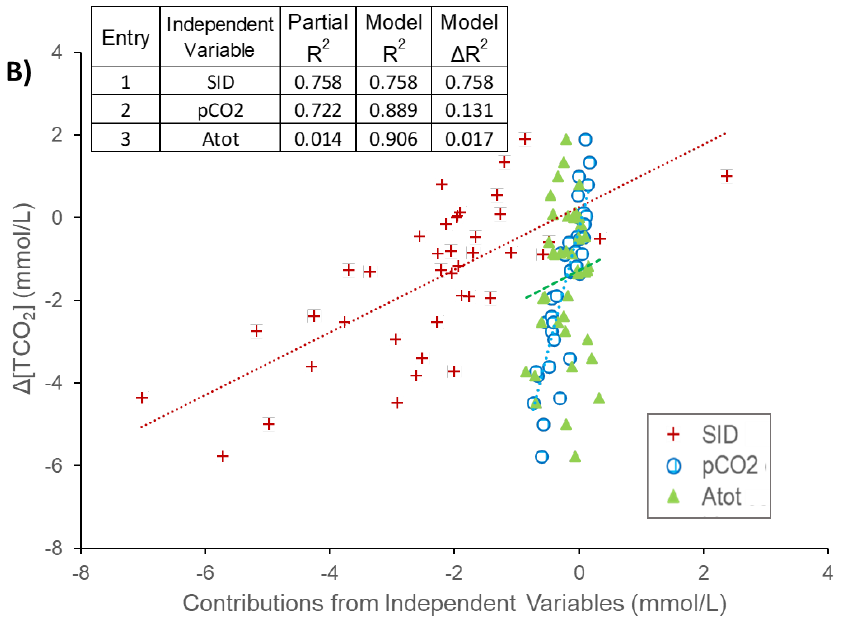
Figure 8. Forward stepwise linear regression analysis confirming the contribution of the independent variables to the changes in plasma dependent variables ( A ) [H + ] and ( B ) [TCO2]. n = 4 horses were administered, in a randomized crossover design, 8L of water as a control (H2O-8; A and B) or 8L of a balanced, hypotonic oral electrolyte solution (PNW-8) 60 min before they exercise on a treadmill at 50% of peak VO2 for 45 min. The independent variables contributing to acid-base state are [SID], strong ion difference; pCO2, partial pressure of carbon dioxide; and [Atot], total weak acid concentration.